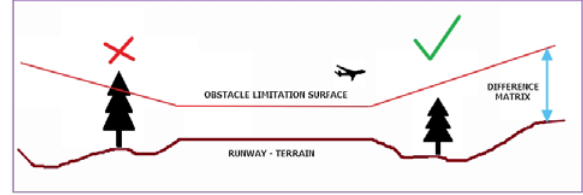
Figure 1. Permissible tree height according to obstacle limitation surface